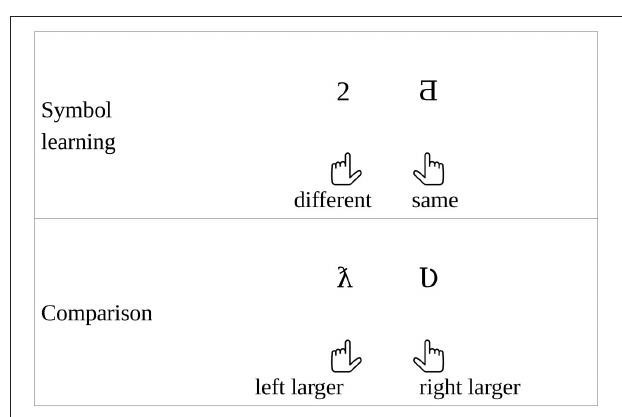
FIGURE 3 | Tasks in the new symbol